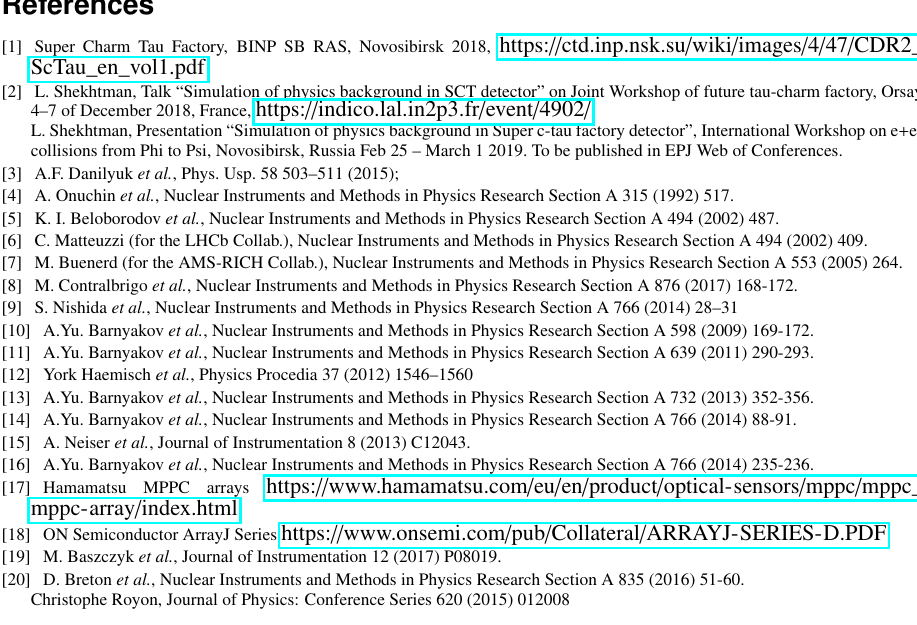
Figure 12. π / K -separation in terms of standard deviation ( σ ) for several PID options obtained with help of parametric simulation: FARICH